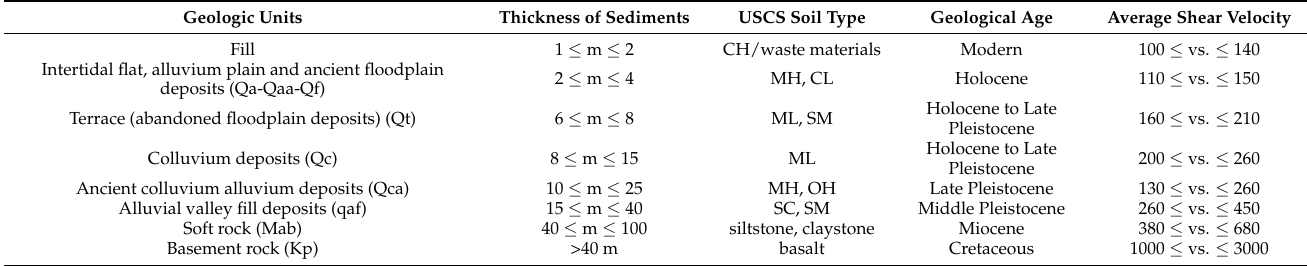
Table 3. Stratigraphic column of the canton of